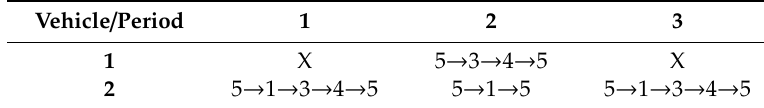
Table 17. Vehicle